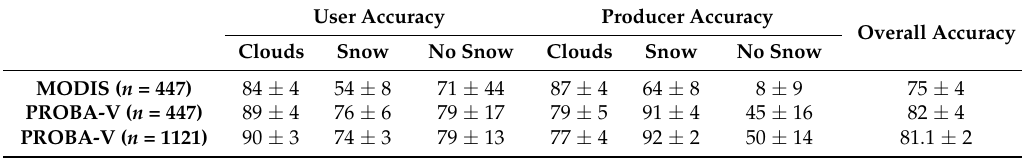
Table 6. Weighted user, producer and overall accuracies of snow classifications of MODIS and PROBA-V with the same points used for the comparison with MODIS (447 points) and PROBA-V with all the points up to 88.5 ◦ SZA (1121 points). Confidence intervals at 95% are also